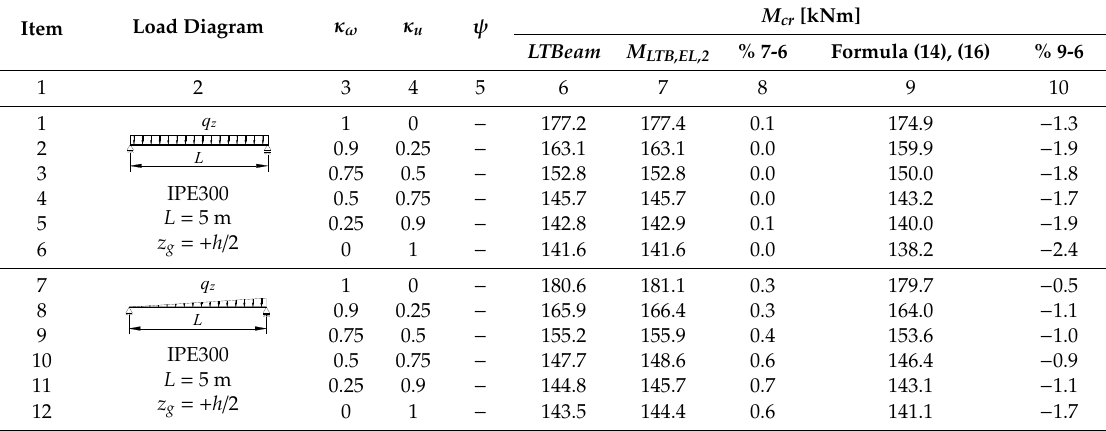
Table 5. Comparison of M cr for beam IPE300 ( L = 5 m).